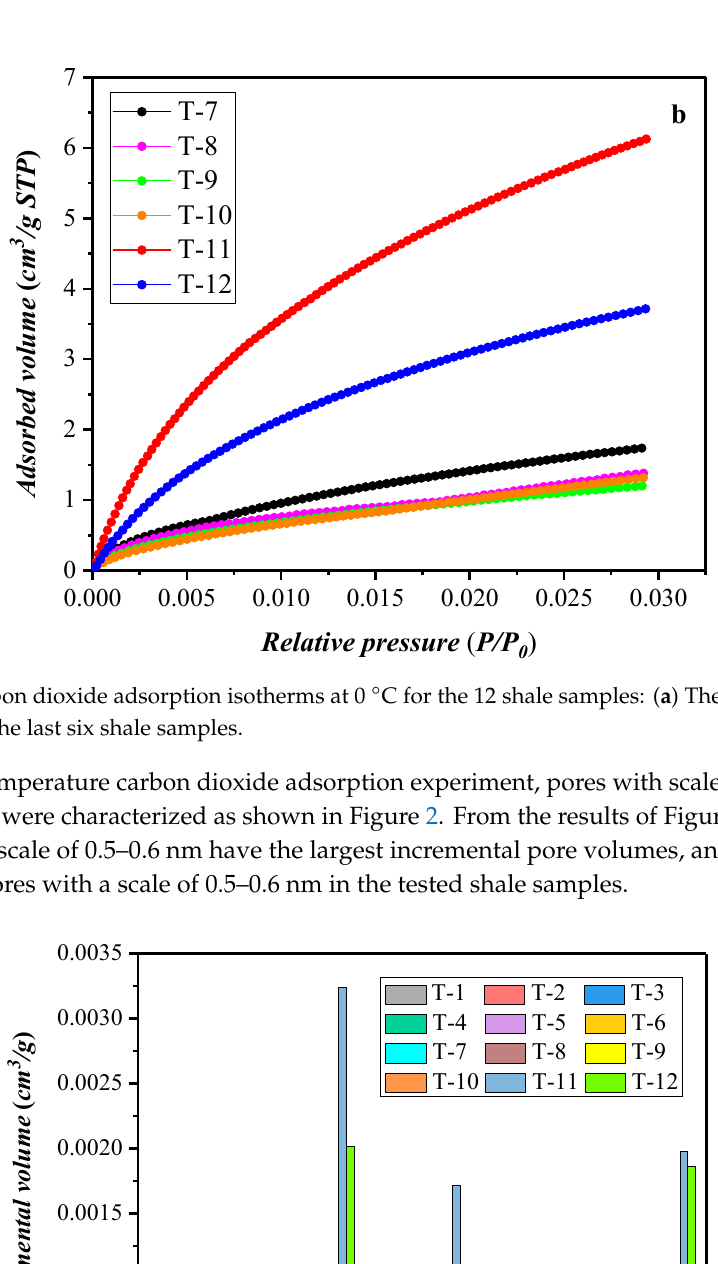
Figure 2. Pore size distribution obtained from the low-temperature carbon dioxide adsorption experiments for the 12 shale samples.